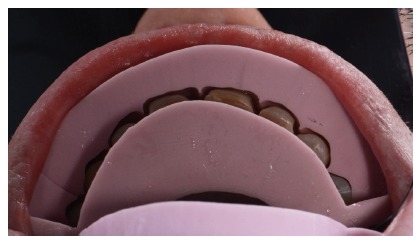
Vestibular guide.